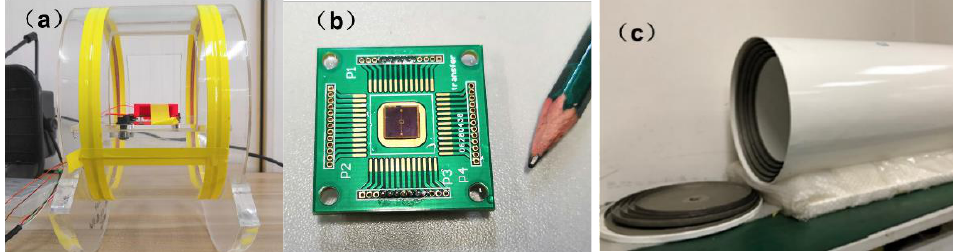
Figure 4. Composition of the test device: ( a ) Helmholtz coil; ( b ) MEMS magnetoelectric antenna; and ( c ) electromagnetic shielding cylinder.